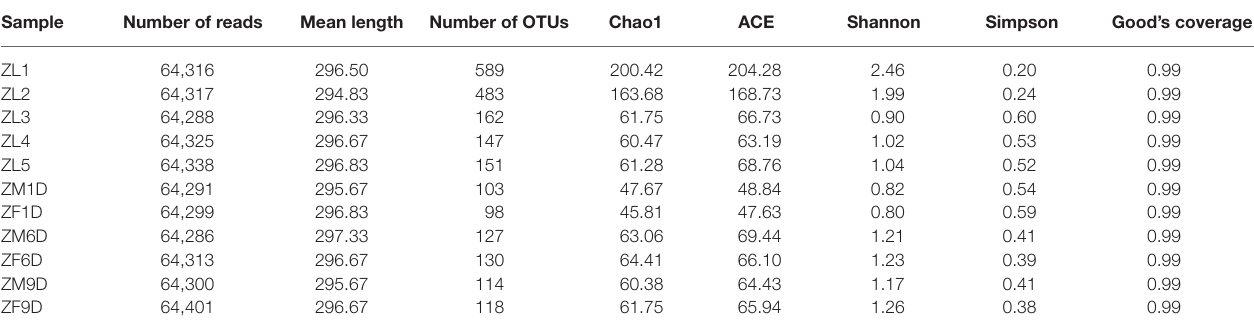
TABLE 1 | 16S rRNA gene sequencing